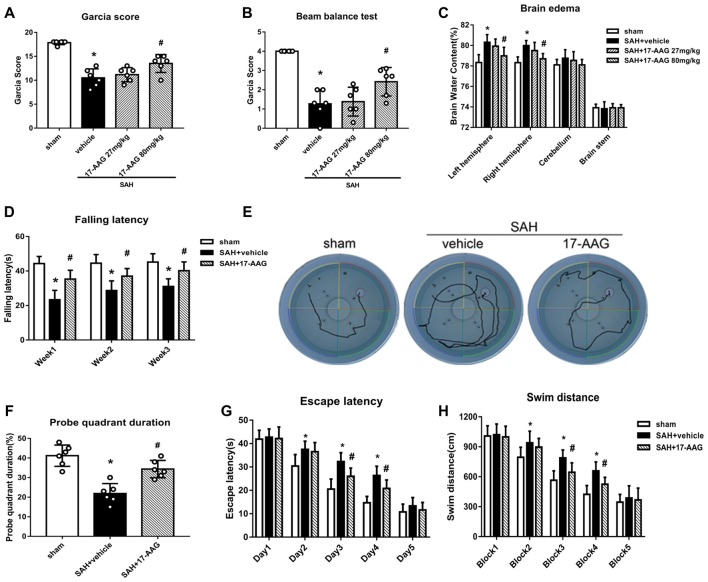
HSP90 inhibitor 17-allylamino-17-demethoxygeldanamycin (17-AAG) improved short- and long-term neurobehavioral outcomes of SAH. (A) Modified Garcia scores and (B) beam balance test scores 48 h after SAH. (C) Brain water content; n = 6 per group. (D) Rotarod test results. (E) Trace map of the Morris water maze test. (F) Time spent in the probe quadrant, (G) escape latency and (H) swimming distance in the water maze test; n = 6 per group. *P < 0.05 vs. sham group; #P < 0.05 vs. SAH + vehicle group. The error bars represent SD.